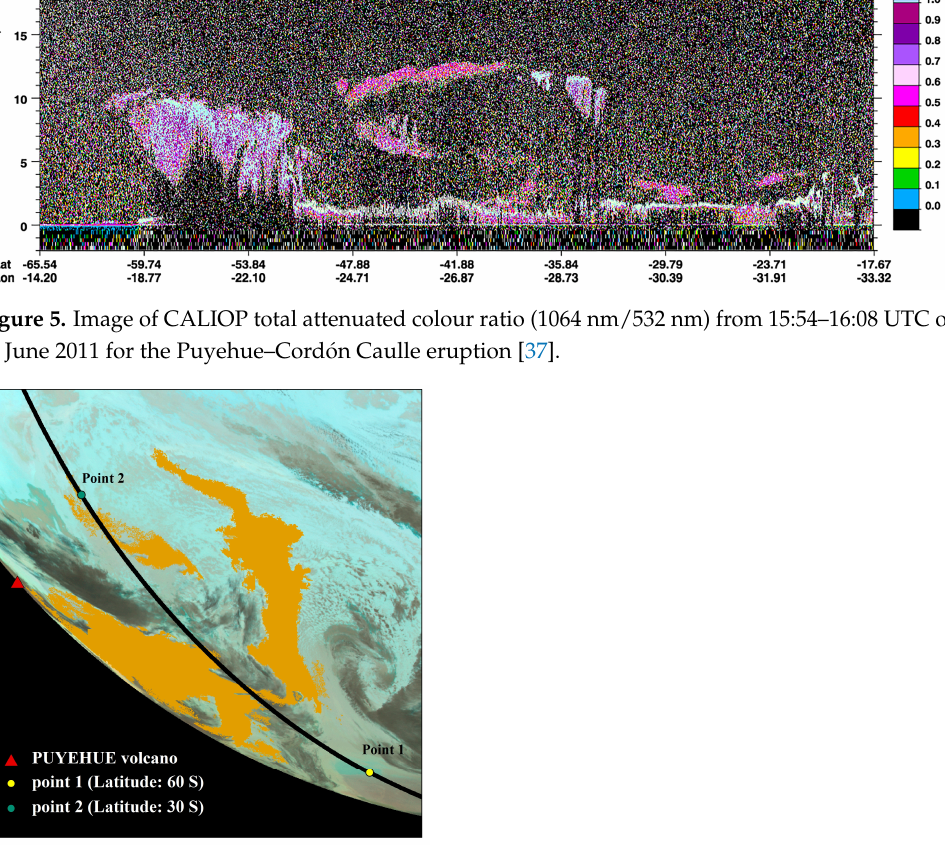
Figure 6. Example of a SEVIRI RGB false-colour image (red=12–10.8 μ m; green=10.8–8.7 μ m; blue=10.7 μ m) for the Puyehue–Cordón Caulle eruption at 16:00 UTC on 16 June 2011. The contem- porary CALIOP overpass (black line) and volcanic ash mask (yellow) are shown.